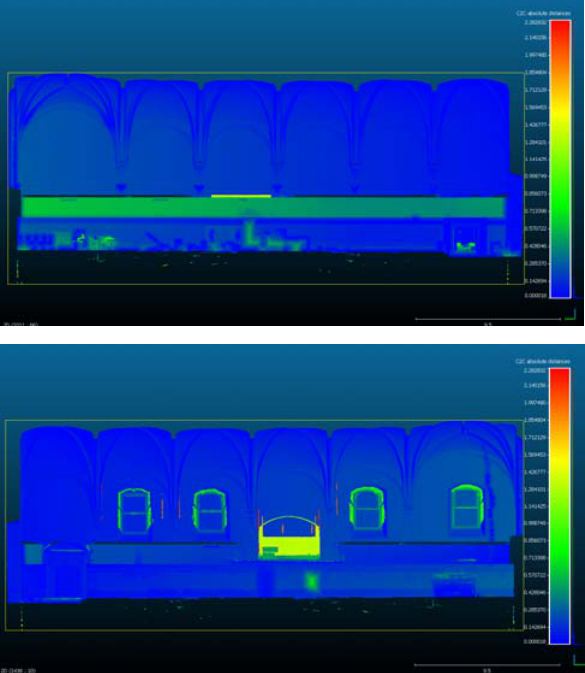
Figure 16: Cloud to cloud comparison (original state and final state) lateral east and